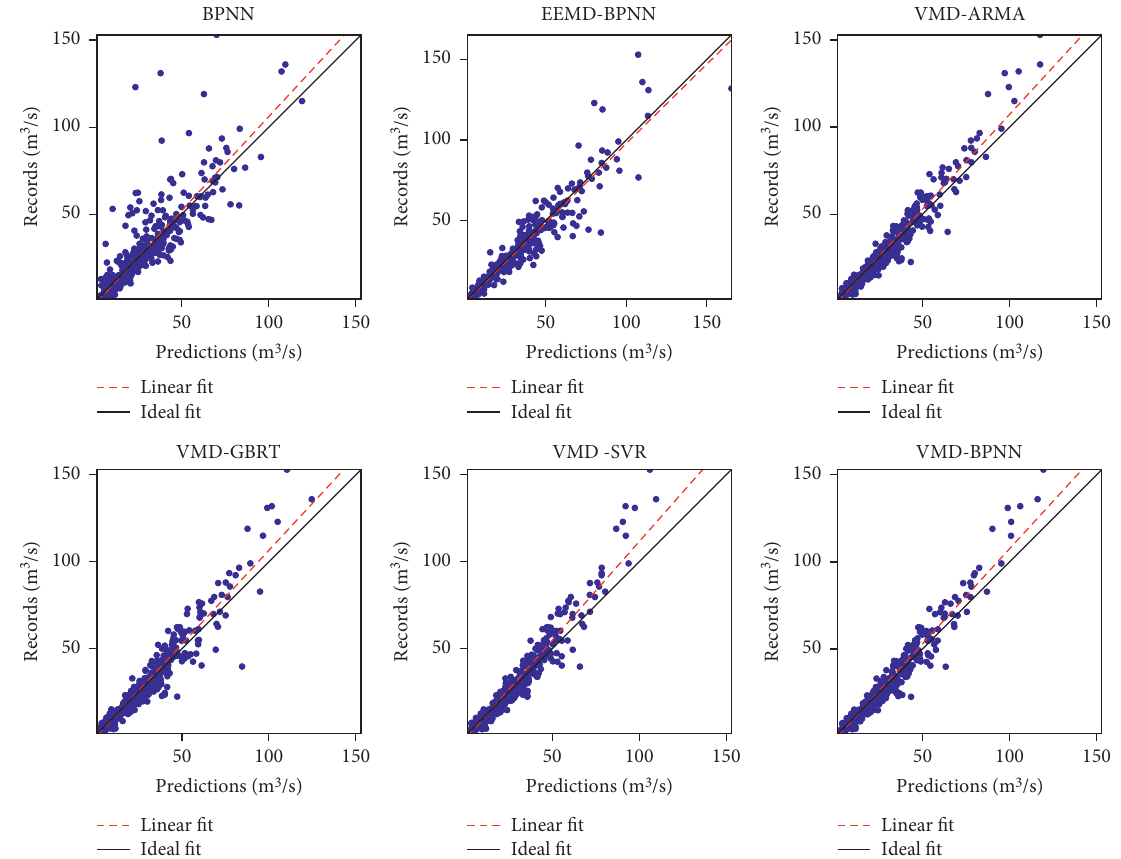
Figure 8: Comparison of scatter plots between the observed and simulated streamflows from the BPNN, EEMD-BPNN, VMD-ARMA, VMD-GBRT, VMD-SVR, and VMD-BPNN models during the testing phase (01/01/2012–31/12/2014) at the Wushan